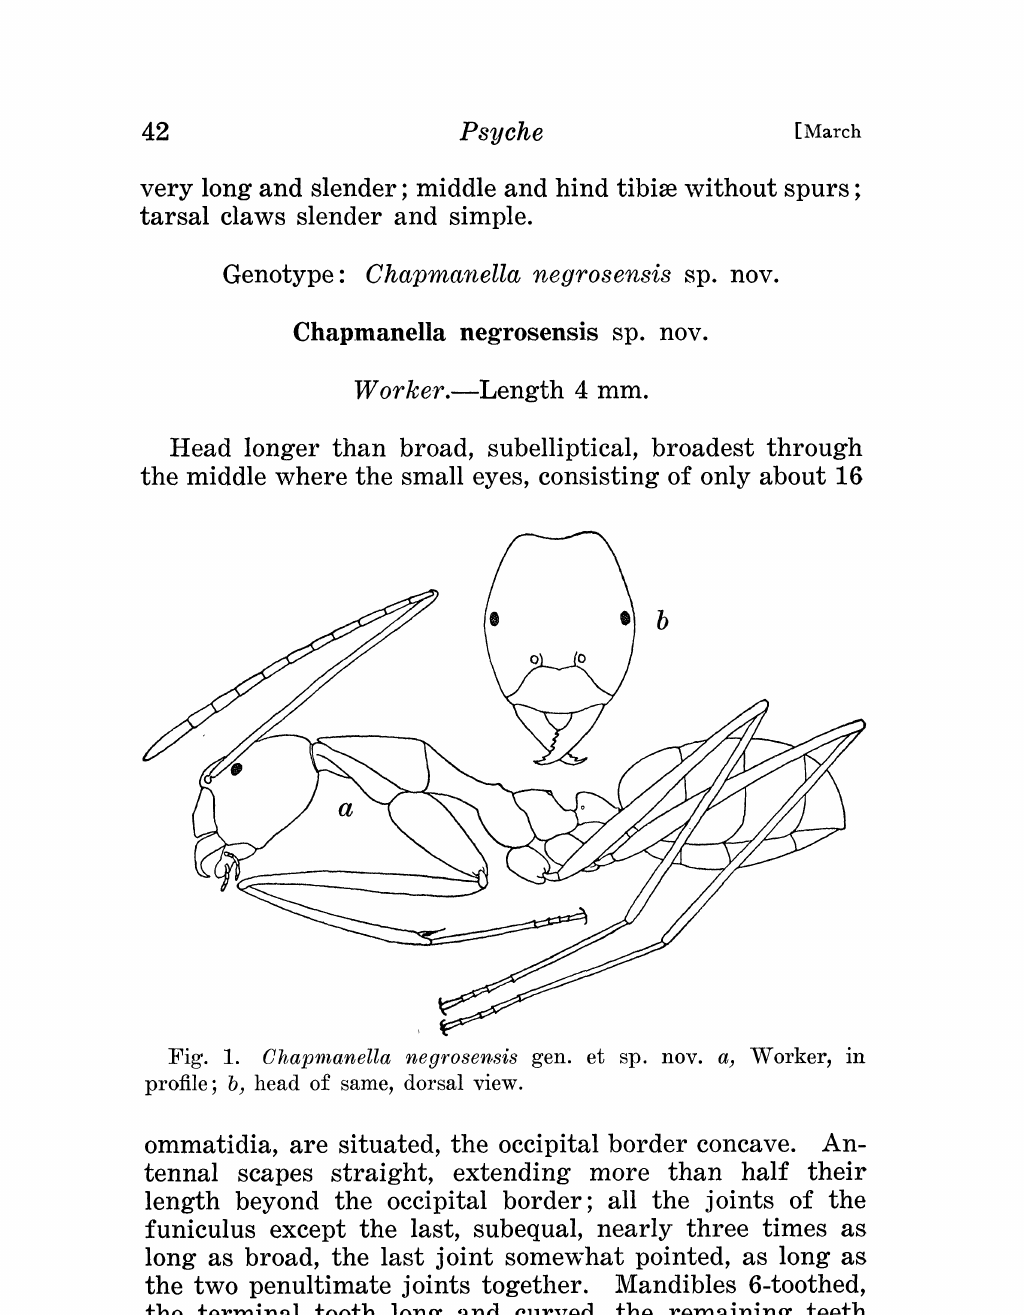
Fig. 1. Chapmanella negrosen.sis gen. et sp. nov. a, Worker, in profile; b, head of same, dorsal